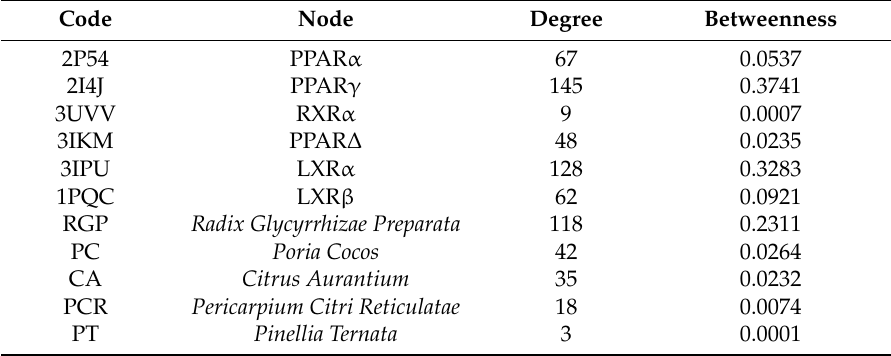
Table 4. Network features of targets and herbs in the herb-compound-target